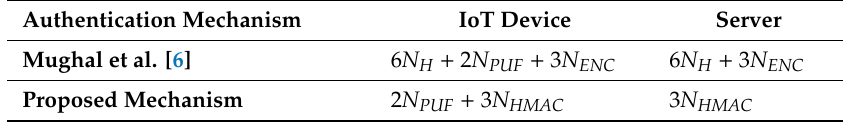
Table 4. Computational complexity comparison between the proposed mechanism and the Mughal et al.’s authentication